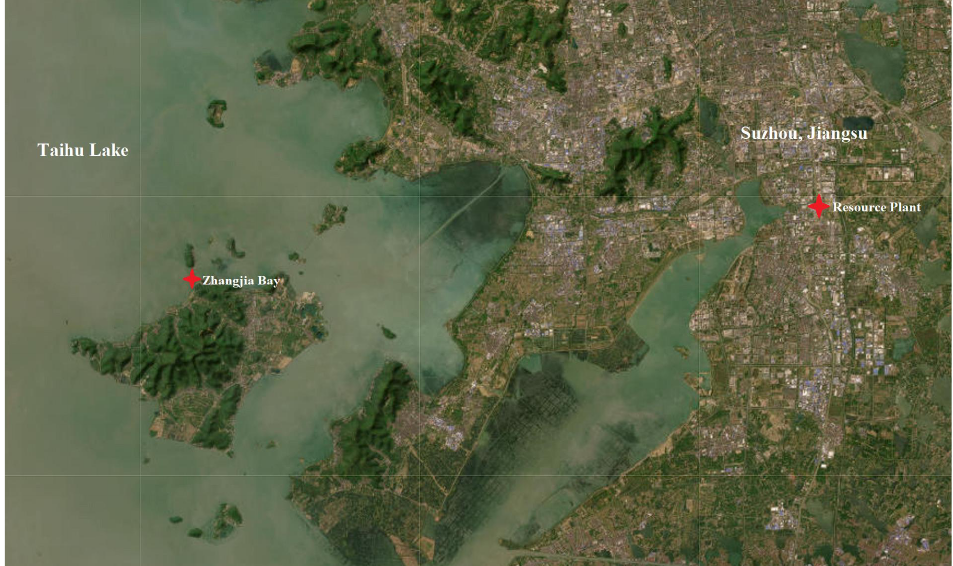
Figure 2. Position map with sampling point and disposal point.